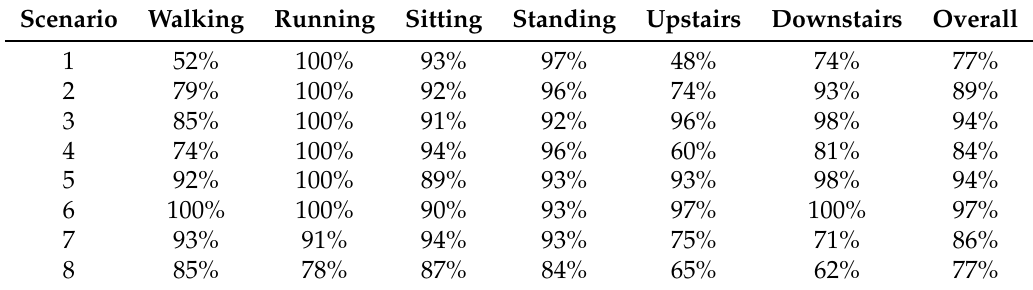
Table 8. Accuracy comparison between our solution and an external solution